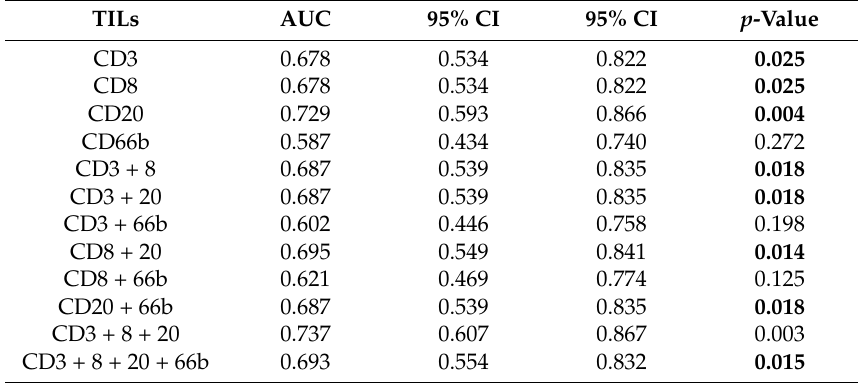
Table 3. Receiver Operating Characteristic (ROC) curves of high vs. low infiltration of immune cells and combined groups regarding the specificity and sensitivity to be alive after 24 months. Area under the curve (AUC). Significant results were bolted ( p < 0.05). CD3 is the marker of T cells,